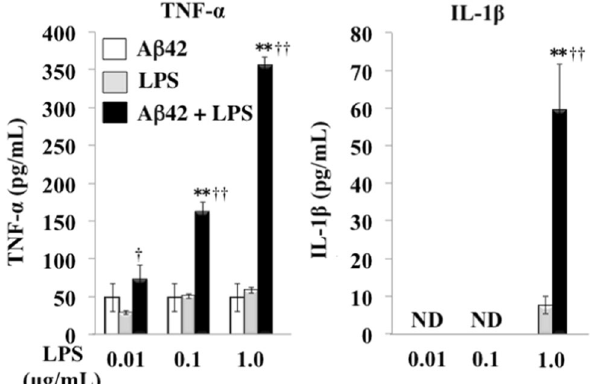
Fig. 6 P. gingivalis LPS enhances A β -induced cytokine production in microglia cell cultures. Microglial cells were stimulated with 10 µM A β 42 for 6 h and further stimulated with P. gingivalis LPS (0.01, 0.1, 1.0 μ g/ml) for 24 h. Amounts of TNF- α and IL-1 β in the media were quanti fi ed by ELISA ( n = 3, mean ± S.D.). ** p < 0.01 vs. A β 42 alone; † p < 0.05, †† p < 0.01, vs. LPS